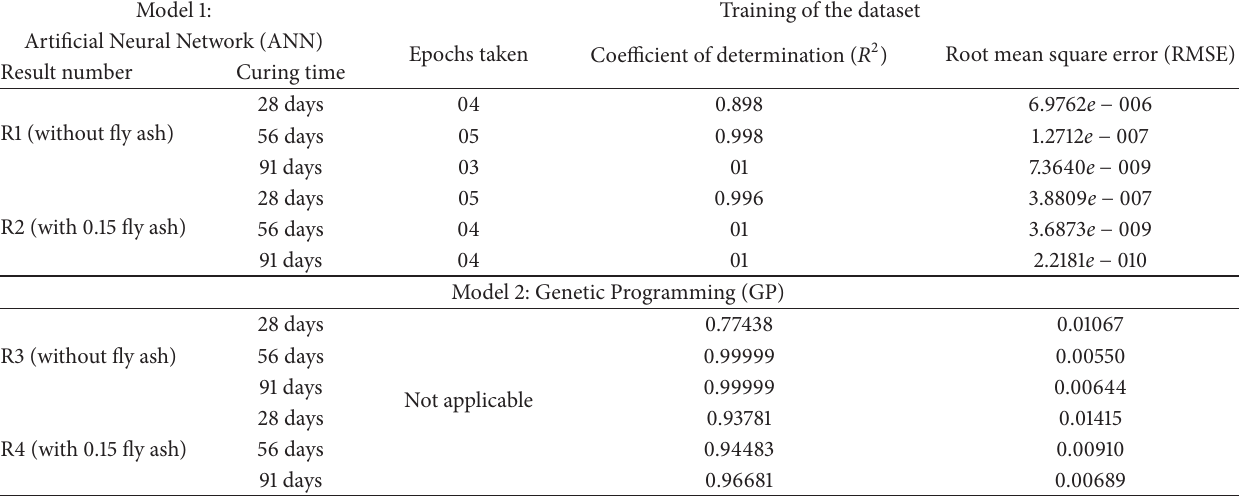
Table 7: Results of model 1 (ANN) and model 2